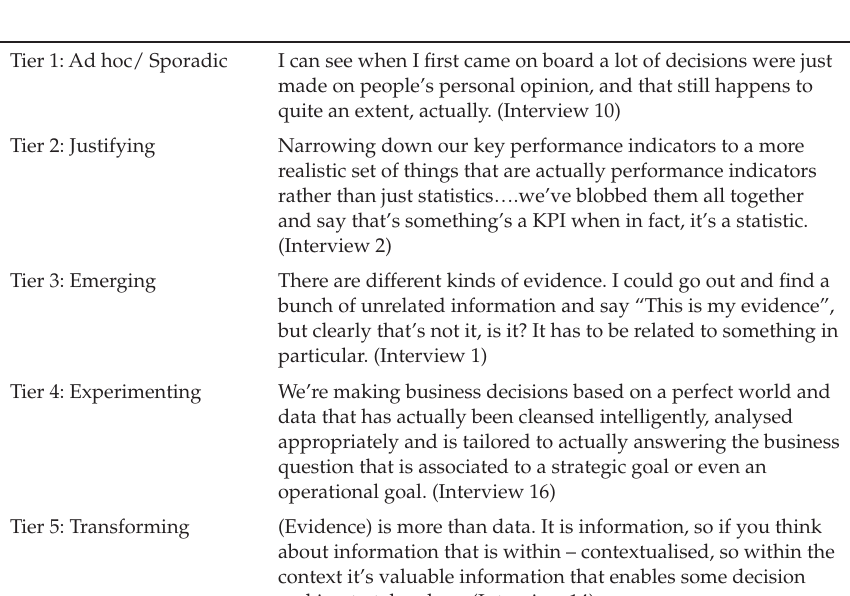
Table 3: Interviewees’ experience of the Evidence dimension, Evidence Based Library and Information Practice Capability Maturity